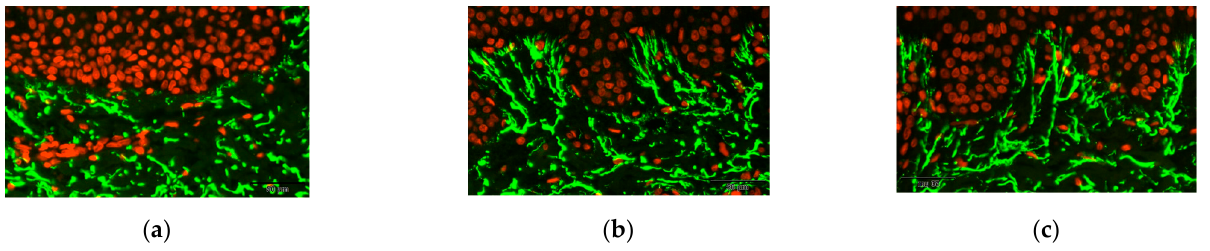
Figure 8. Elastin immunostaining in the papillary dermis of the batches irradiated with infrared on D6 ( a ), irradiated with infrared and pre-treated with the Melissa officinalis phytocomplex at 0.05% ( b ) or 0.1% w/v ( c ), on D6.